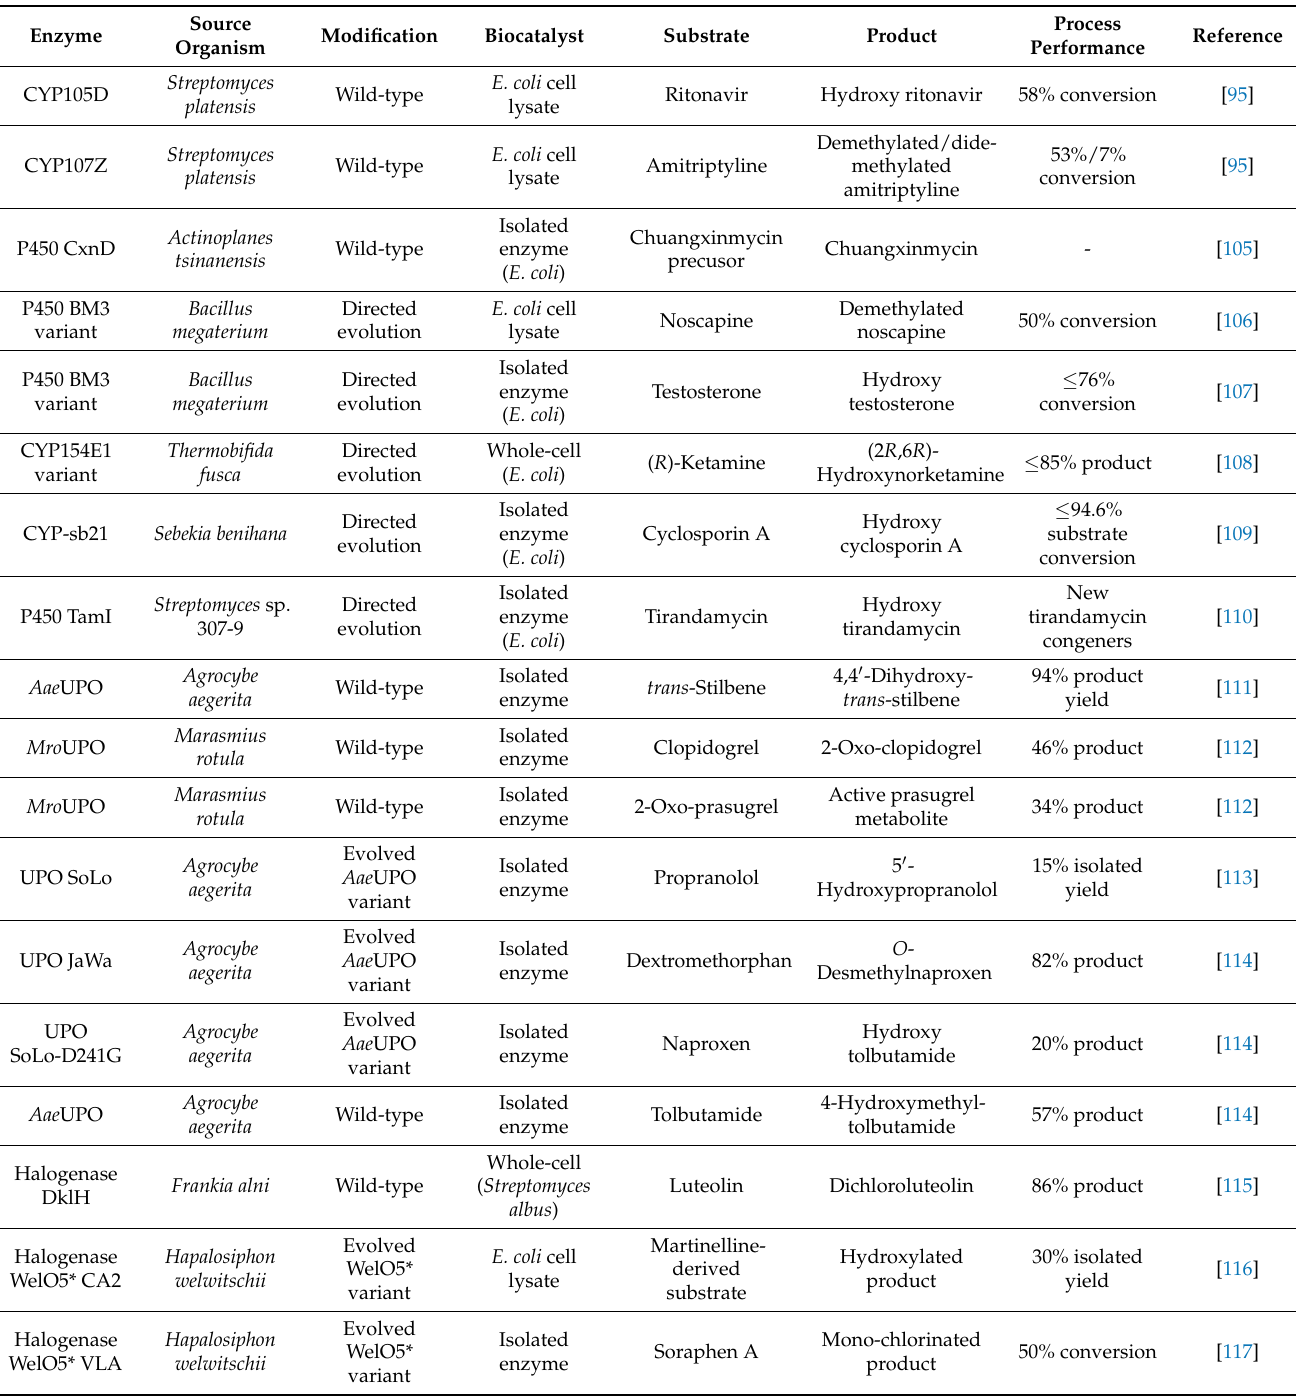
Table 3. Overview of mentioned enzymes catalyzing diversifications and late-stage